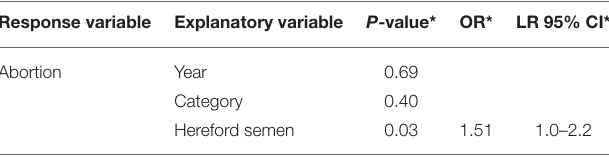
TABLE 3 | Results from logistic regression to estimate effect of using Hereford semen on seropositive dairy